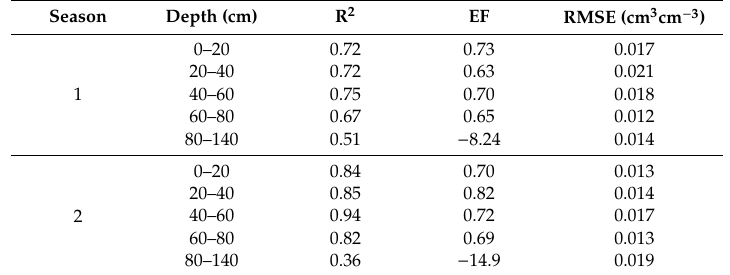
Table 4. Statistical analysis of the comparison between observed and simulated water